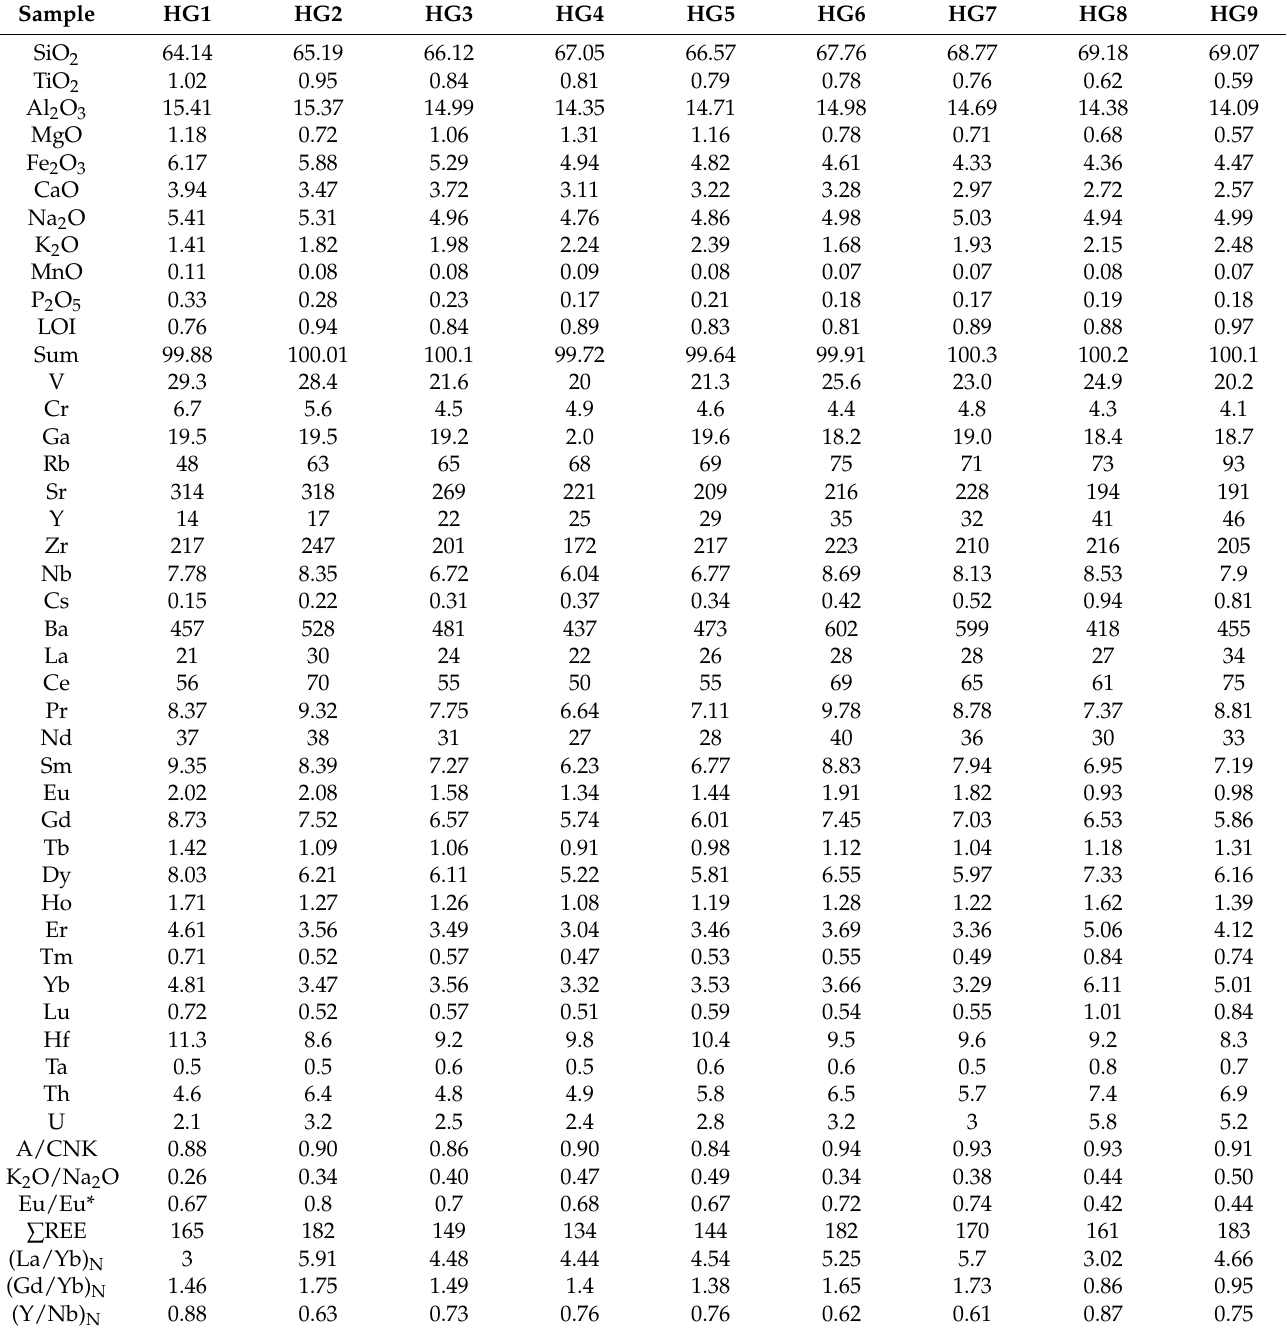
Table 2. Analytical data of whole-rock major and trace elements and related parameters of the Haweit granodiorites, NE